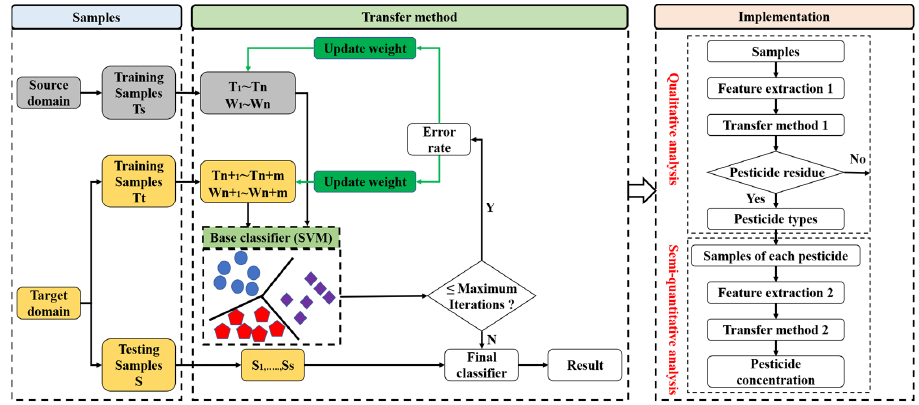
Figure 4. The fl owchart of the methodology applied for identifying the pesticides in groundwater. Figure 4. The flowchart of the methodology applied for identifying the pesticides in